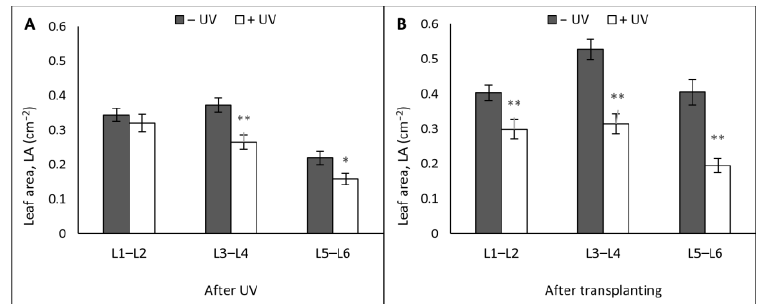
Figure 6. The parameter measured was the leaf area (cm 2 ) across leaf L1–L2, L3–L4, and L5–L6 after the UV ( A ) or after transplanting ( B ). Before the UV exposure stage, the mean of the leaf area for L1–L2 was 0.274 cm 2 , for L3–L4 was 0.264 cm 2 and for L5–L6 was 0.113 cm 2 . Asterisks indicate a significant difference between the UV treatments with p < 0.05 (*) or p ≤ 0.001 (**).